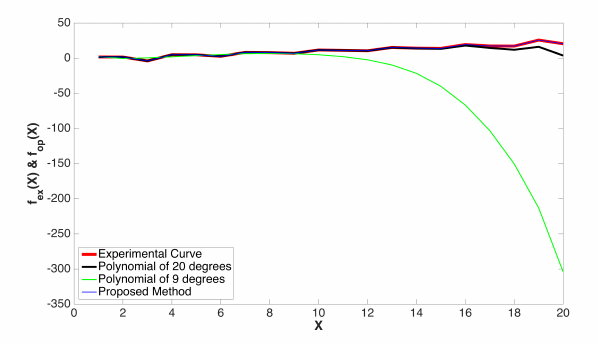
Figure 5. Proposed method and polynomial interpolation comparison.